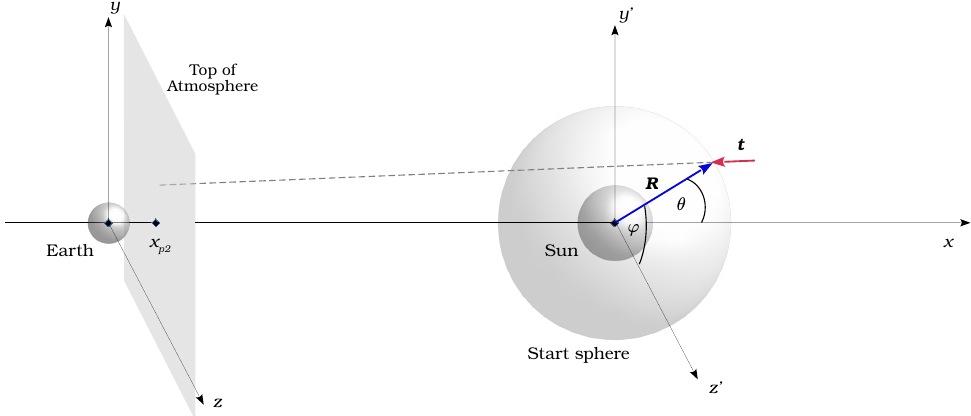
Figure 2. The coordinate system used in the modified version of the PRESHOWER simulator. The dashed line shows the primary photon trajectory. The purple vector t is the primary photon direction, which is randomly generated. The blue vector R indicates the simulation starting point; its length R is the simulation input parameter, whereas the polar angle θ between the vector R and the x axis and the azimuthal angle ϕ in the y (cid:48) z (cid:48) plane is randomly generated. The x p 2 point determines the top of the atmosphere plane x = x p 2 , but it is no longer the primary photon arrival